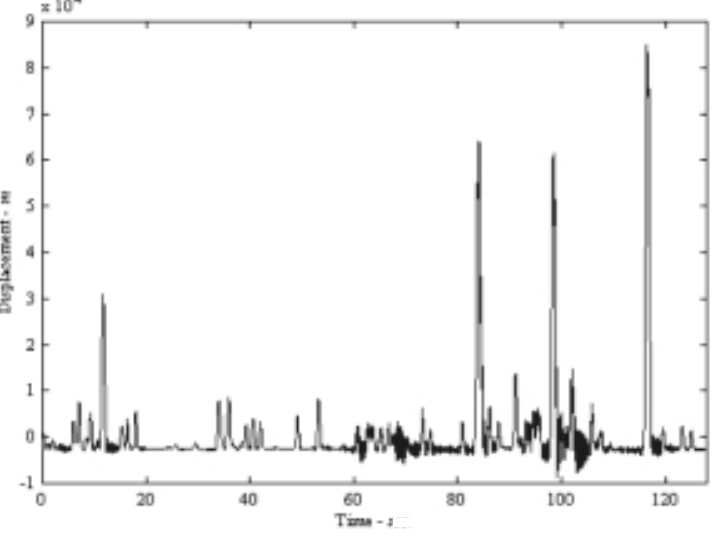
Fig. 7. Typical long time displacement record measured by the vibrometer.